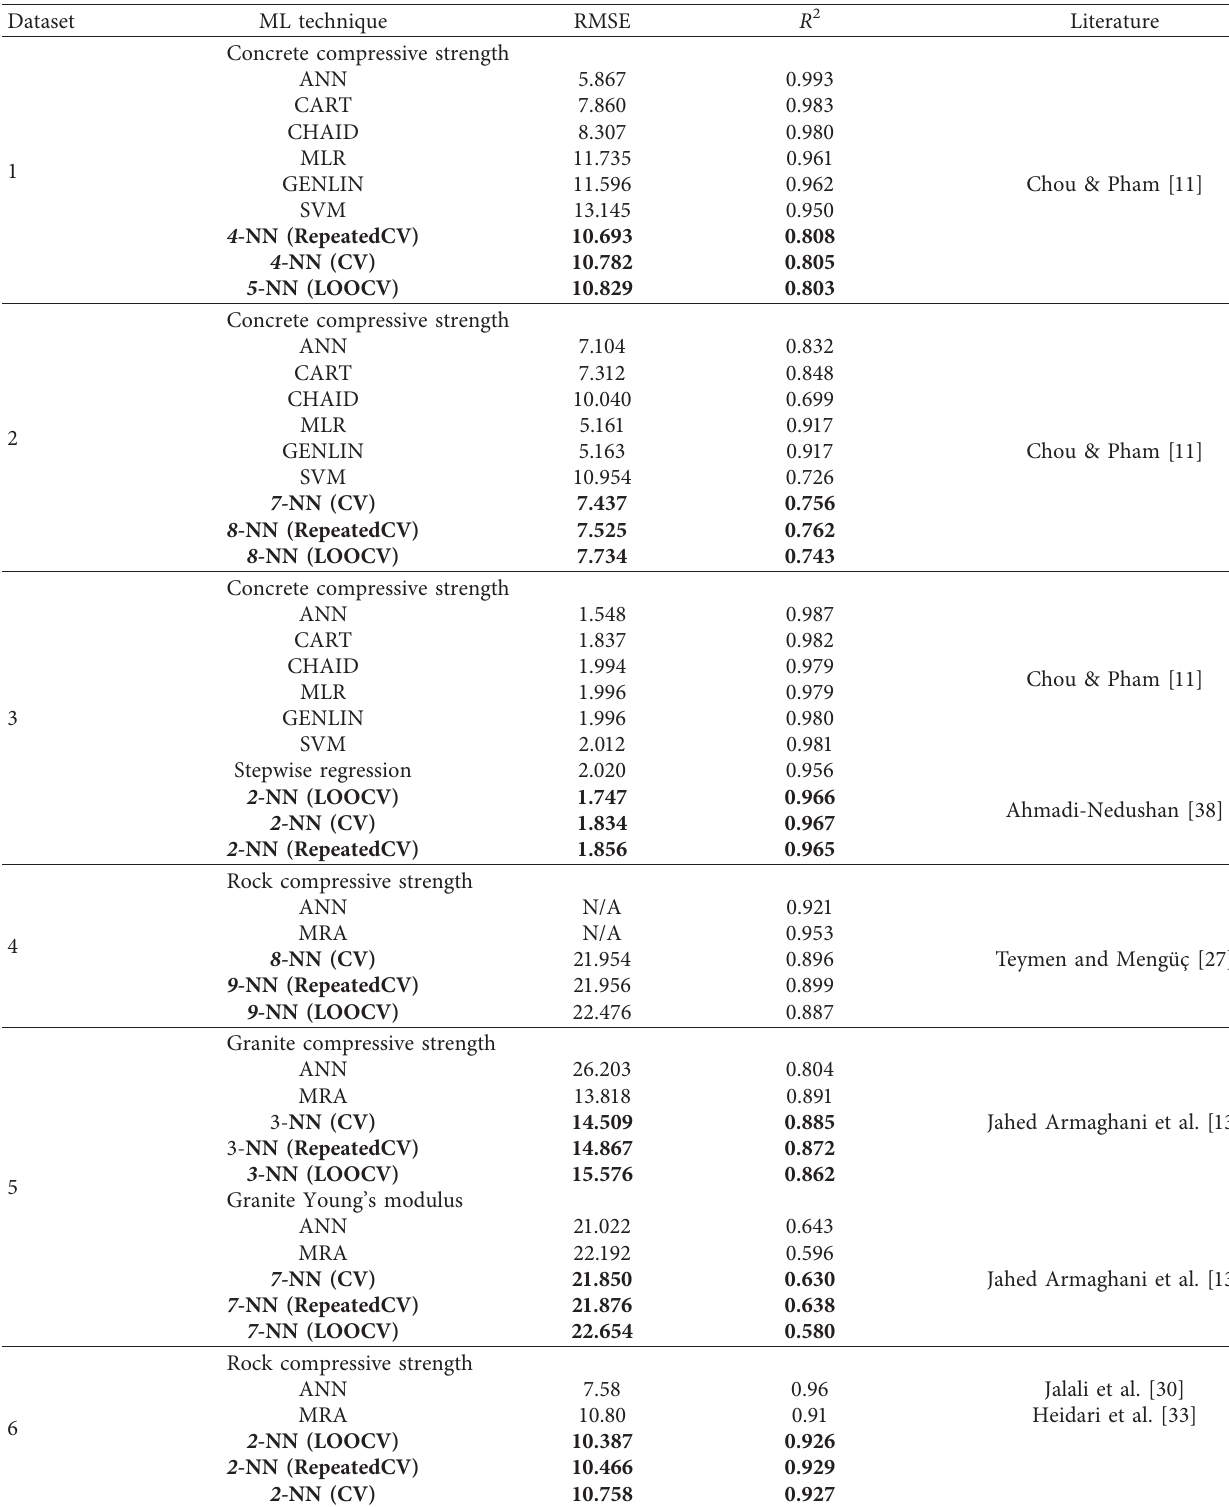
Table 6: Prediction performances of individual